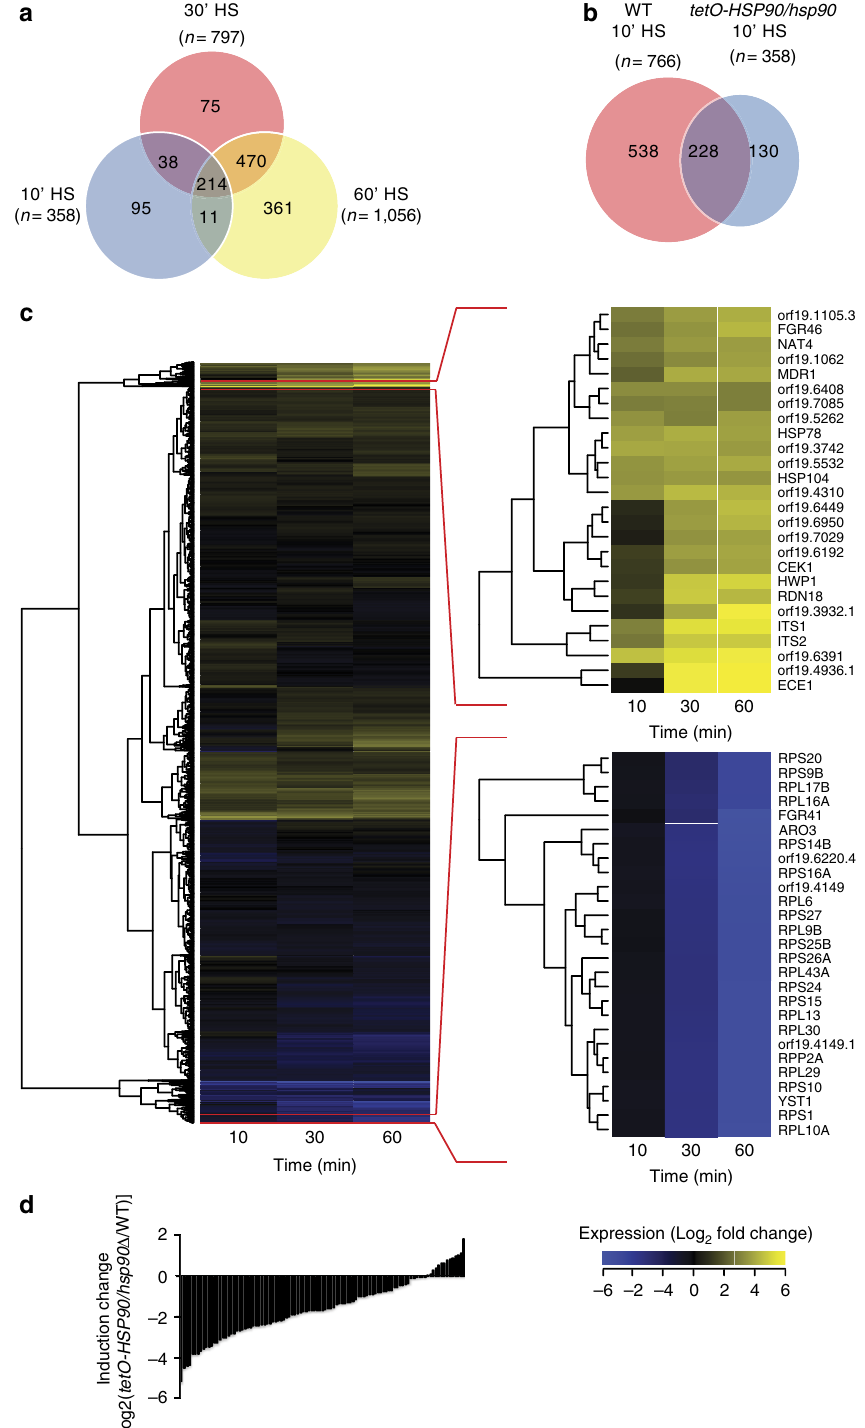
Figure 5 | Depletion of Hsp90 changes the genome-wide heat shock signature. ( a ) Venn diagram depicting number of upregulated genes 10, 30 and 60min post 30–42 (cid:2) C HS in HSP90 -depleted cells. Overlap between samples is illustrated, with the total number of genes upregulated at each time point represented under each time point. ( b ) Venn diagram illustrating gene expression overlap between wild-type and tetO-HSP90/hsp90 D strains 10min post 30–42 (cid:2) C HS. ( c ) Expression pattern of the tetO-HSP90/hsp90 D strain grown in the presence of 20 m gml (cid:2) 1 doxycycline for transcriptional repression of HSP90 compared with the same strain 10, 30 and 60min post 30–42 (cid:2) C heat shock. Yellow represents greater than Log 2 -fold increase in gene expression, blue represents a Log 2 -fold or greater decrease in gene expression. Columns represent individual time points. ( d ) Histogram illustrating the effect of HSP90 depletion on heat-induced expression changes of Hsf1 target genes. Transcription induction (increase in PolII level) of Hsf1-target genes upon heat shock in the absence of HSP90 was compared with that in wild-type, and the differences (induction change) are expressed in log 2 scale. HS, heat